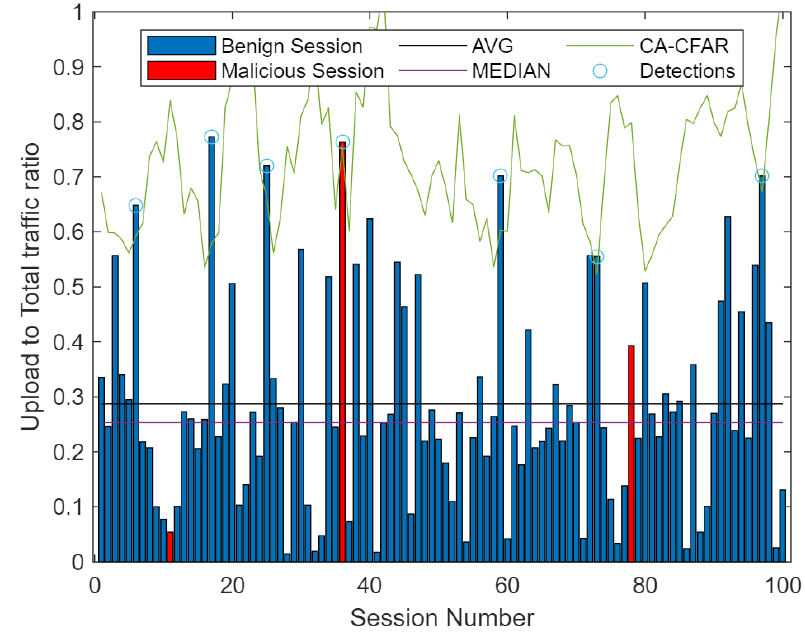
Figure 16. The designated threshold for 10 training cells and 2 guards cells. Upload ratio.